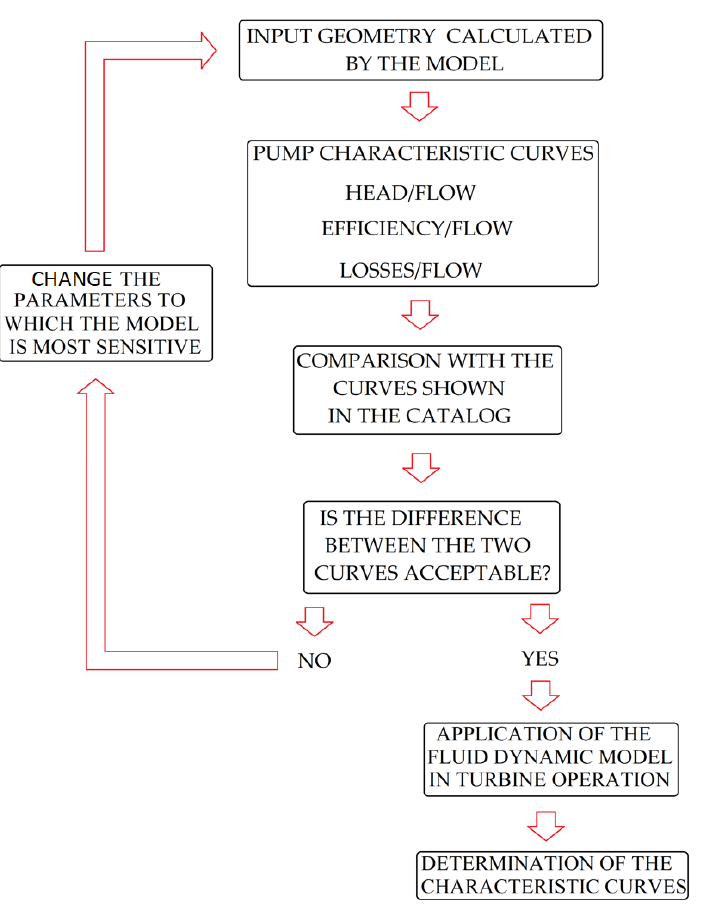
Figure 13. Global procedure for determining the performance curves.